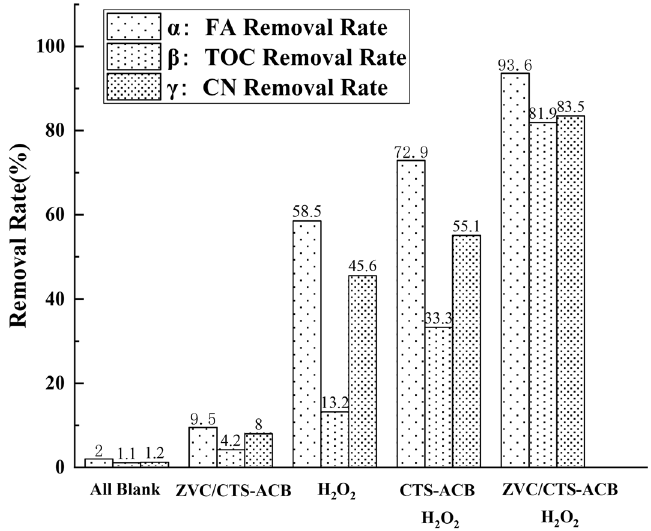
Figure 6. Catalyst and oxidant controlled trials (FA = 100 mg/l, temperature = 94 °C, time = 90 min, pH 3.8, CTS-ACB and ZVC/CTS-ACB = 4 g/l, H 2 O 2 = 20